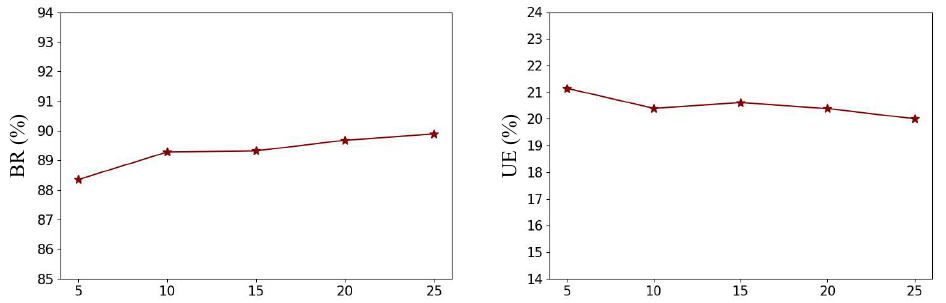
Figure 10. Quantitative comparison of superpixel generation results with different v . ( left ) BR curves. ( right ) UE covers. ( K = 400 and λ =